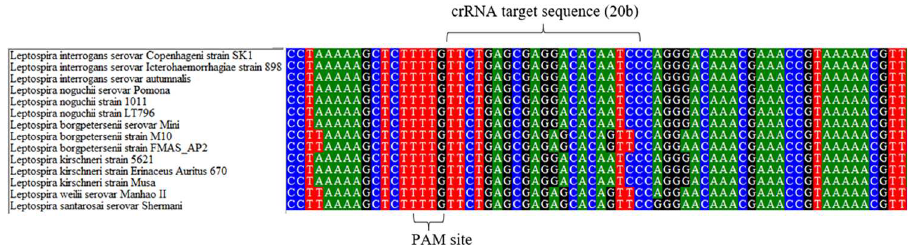
Fig 4. The Bioinformatics analysis of lipL32 multiple sequence alignment between pathogenic Leptospira . Sequence accession numbers are as follows, CP048830.1, CP043891.1, EU526391.1, AY609326.1, AY461918.1, AY461920.1, AY609333.1, AY568680.1, NZ_CP072630.1, AY461917.1, AY461912.1, AY461911.1, AY609331.1, and CP006694.1.